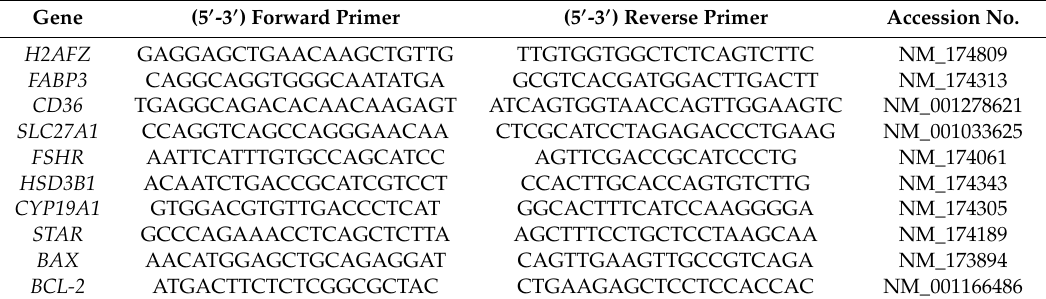
Table 1. Bovine specific sequences of primers used for real-time